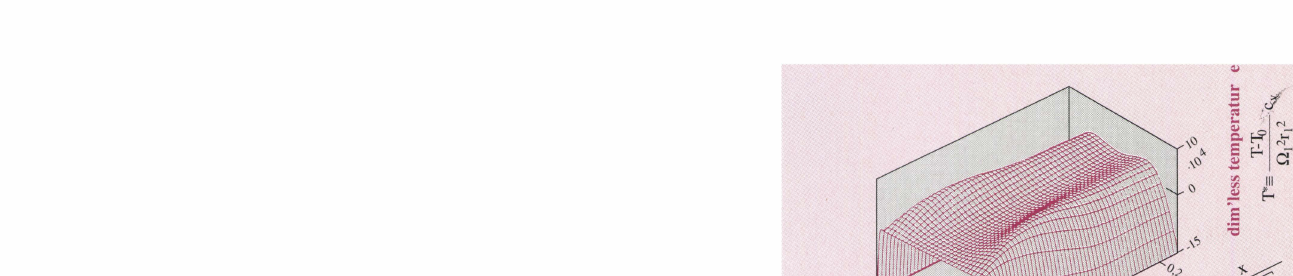
Fig. 5: Temperature in the calender annulus for a dimensionless temperature of the rolls of 't*= - 1.55 .